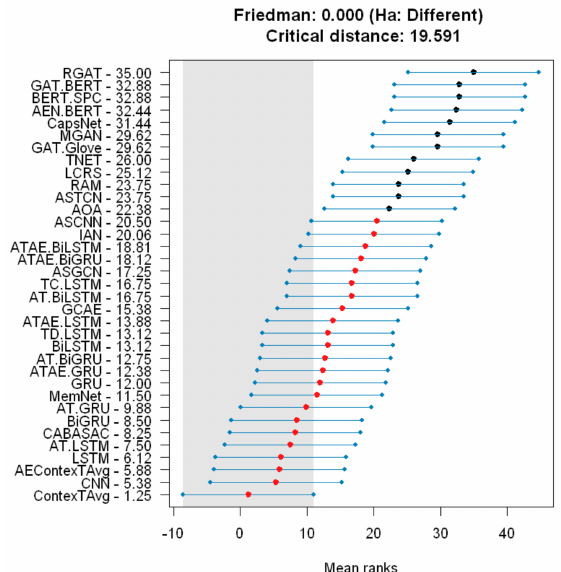
Figure 8. Nemenyi test Critical Distance diagram for 35 deep learning methods for Time. Nemenyi Test